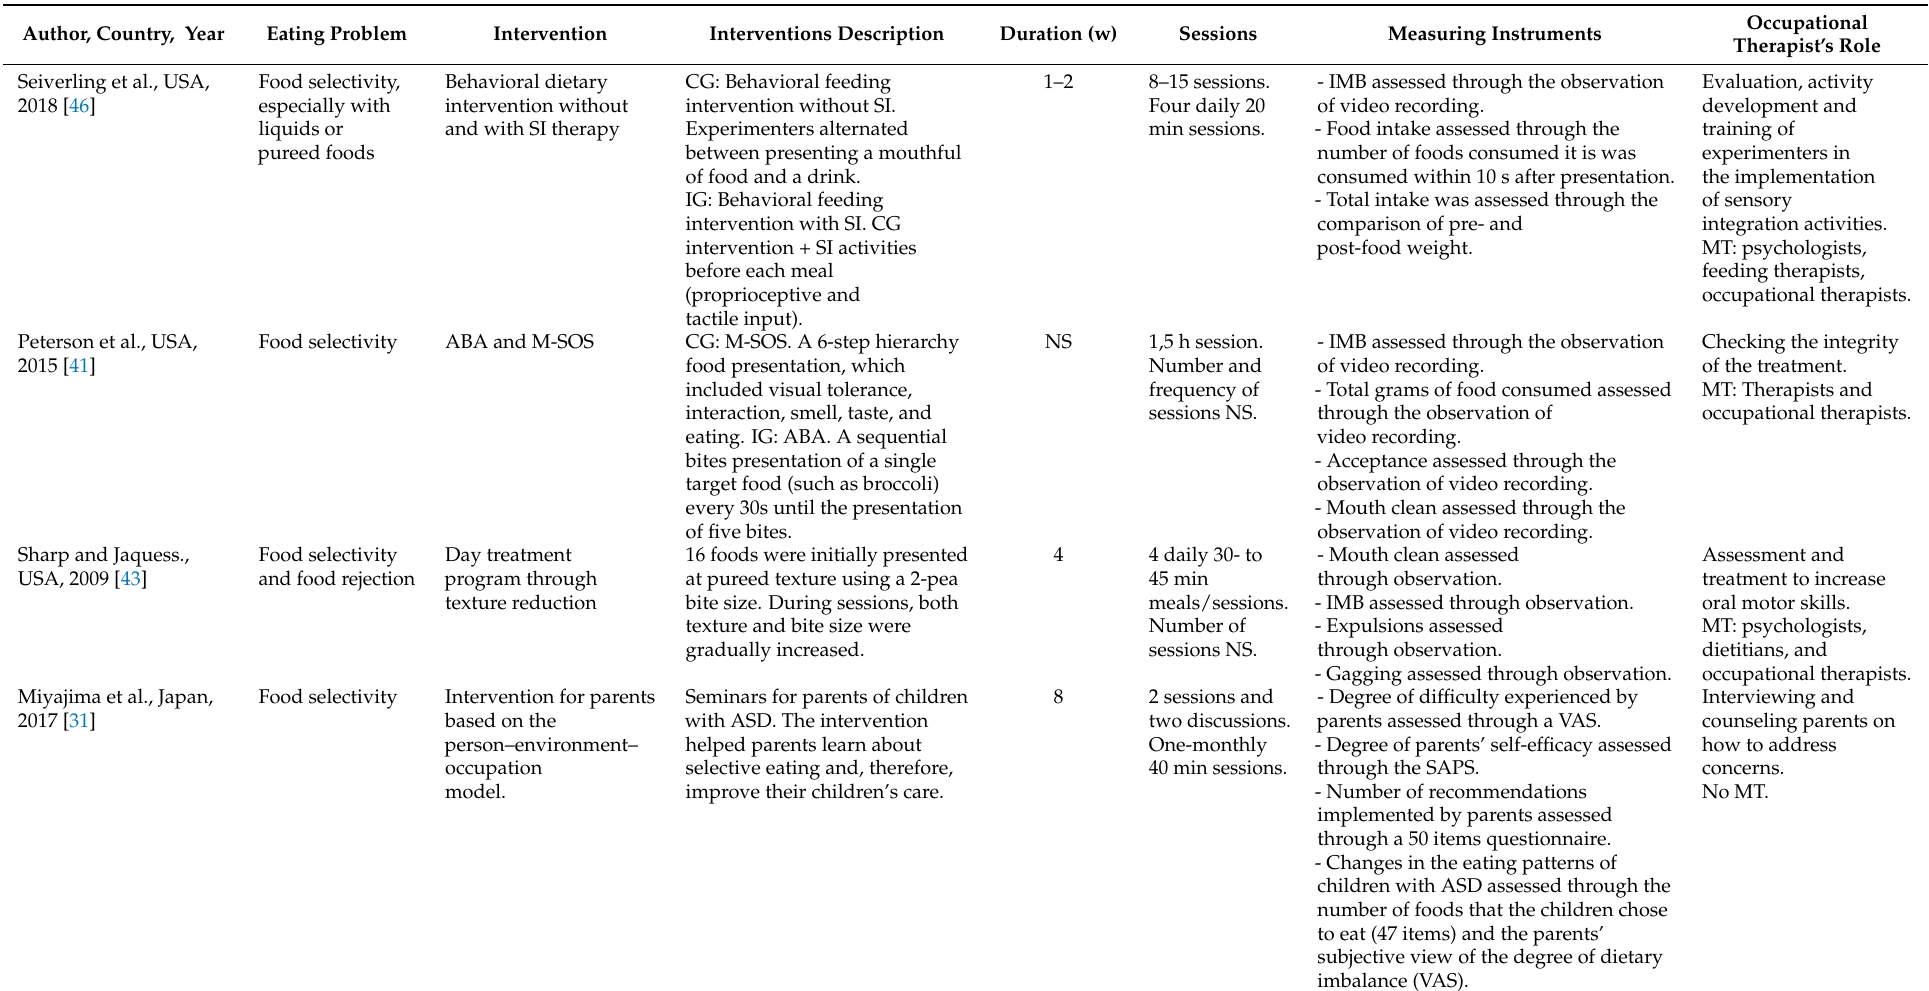
Table 2. Characteristics of the interventions carried out in the studies included in this scoping